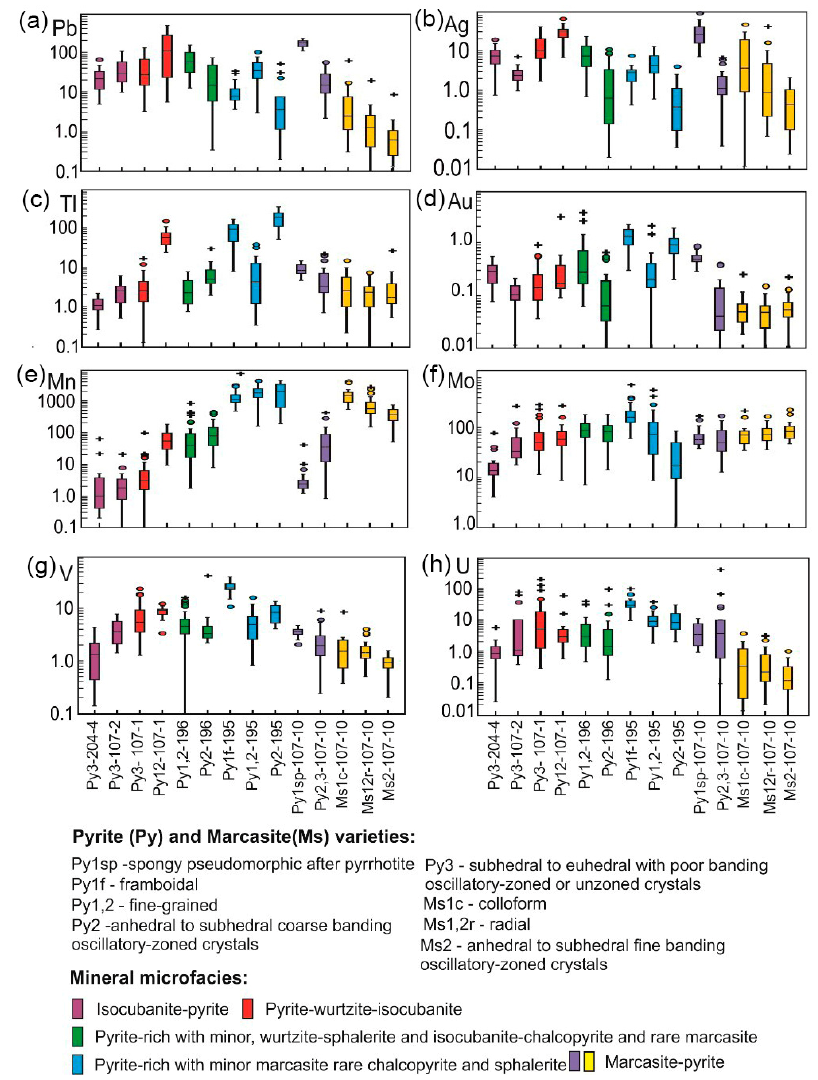
Figure 12. Whisker-and-box plots for the low-temperature (Pb ( a ), Ag ( b ), Tl ( c ), Au ( d ), and Mn ( e )) and seawater-derived (Mo ( f ), V ( g ), and U ( h )) association of elements in pyrite and marcasite ranged in isocubanite-rich to pyrite and marcasite-pyrite rich microfacies. The box encloses the interquartile range with median displayed as a line. The vertical lines extending outside of the box mark the minimum and maximum element concentrations encountered. Outliers are plotted as single points.